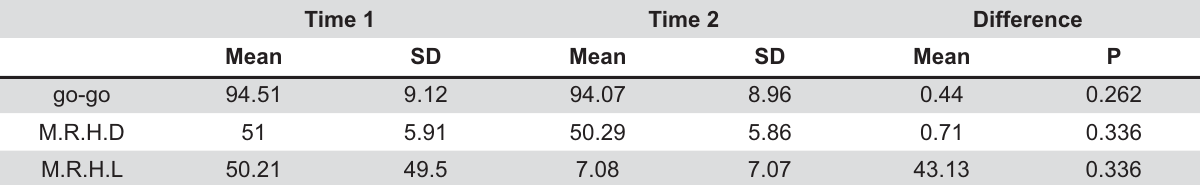
Table 1- Distribution of quantitative variables (N=14) according to t-test to verify the reliability intra-examiner